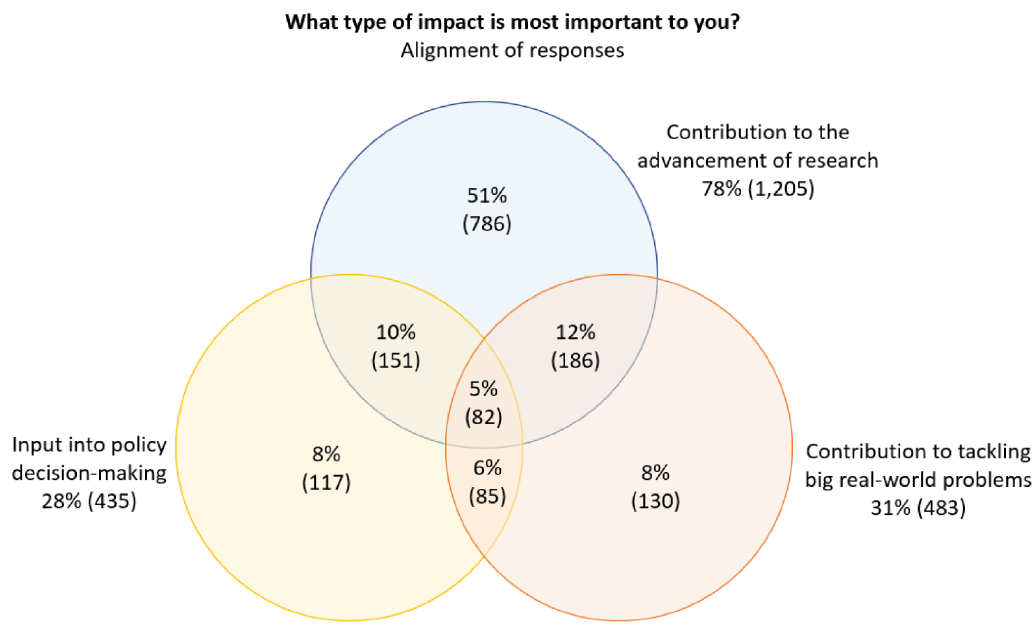
Figure 5. Alignment of selected responses to the question What type of impact is most important to you?